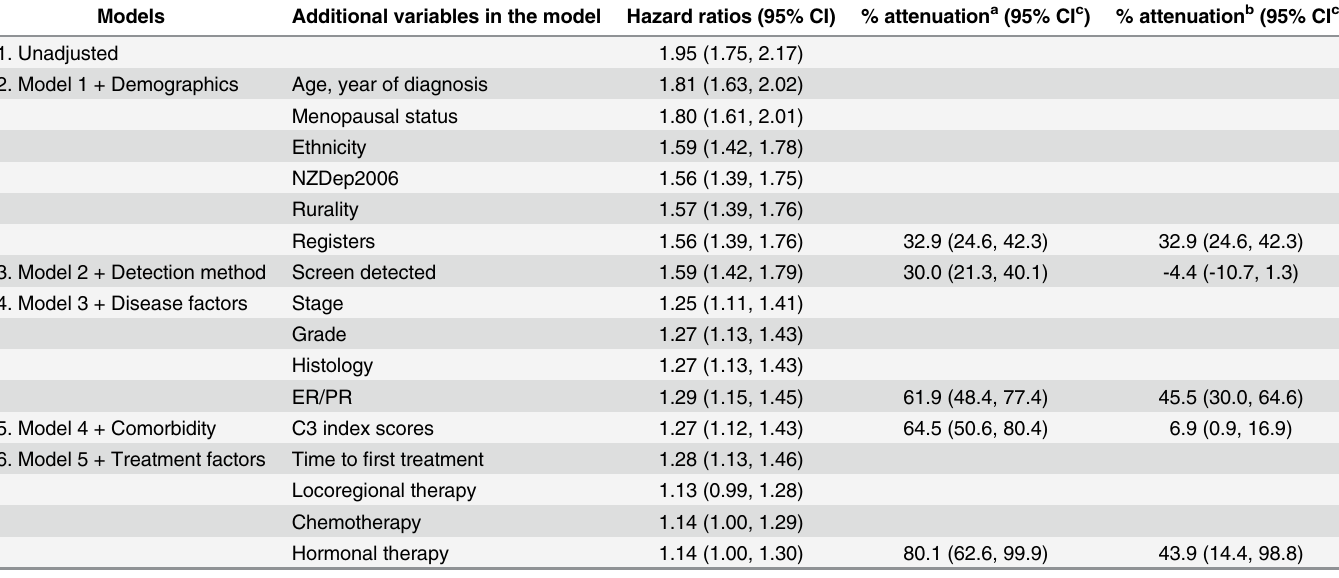
Table 2. Hazards of death from breast cancer by health care facility type with stepwise adjustments.